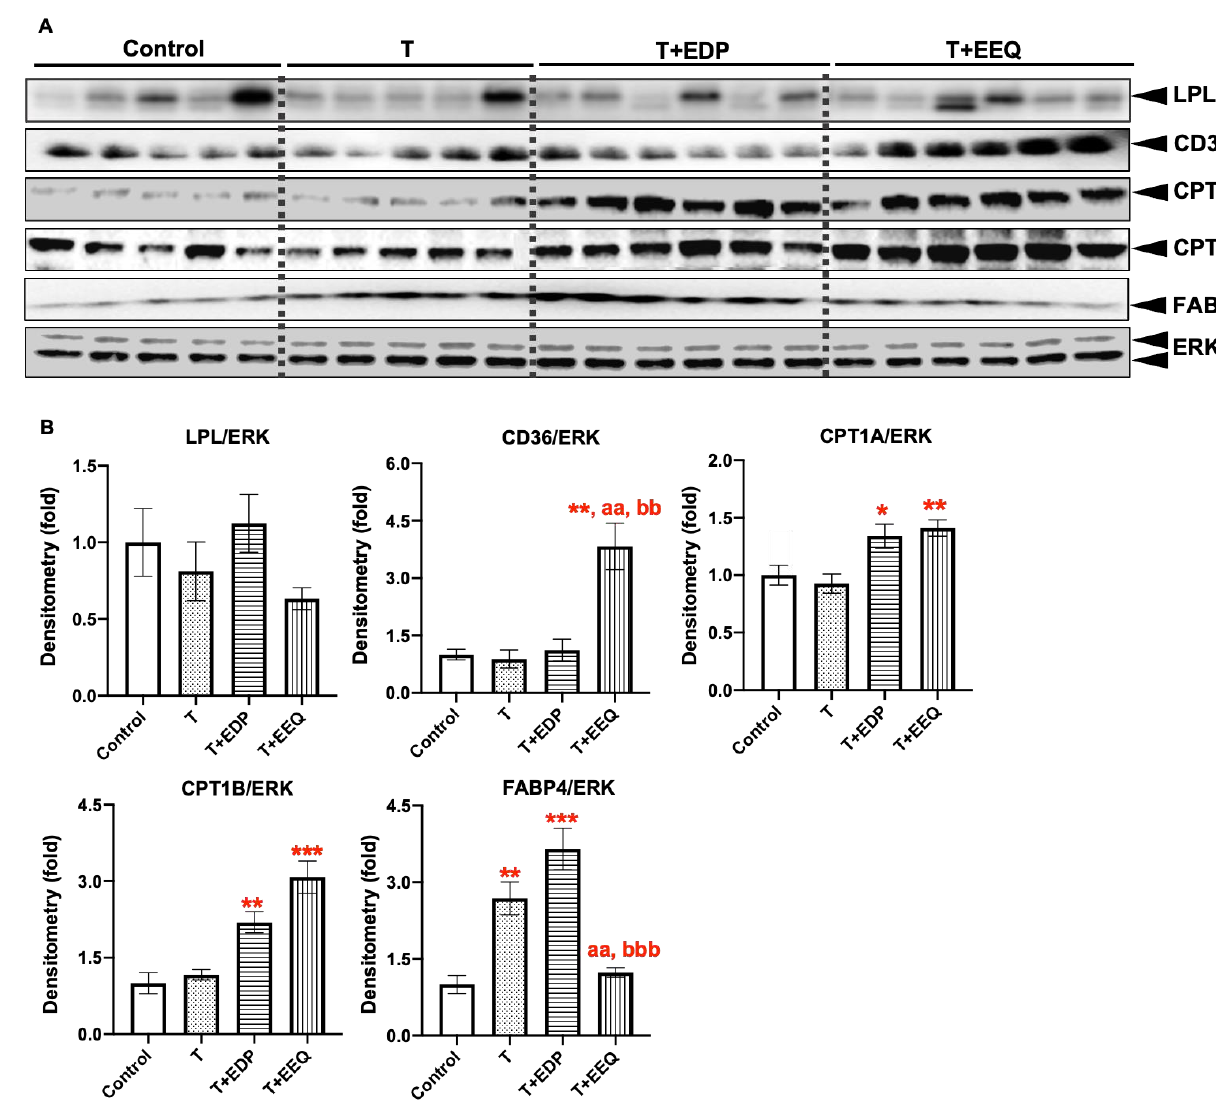
Figure 5. 17,18-EEQ or 19,20-EDP combined with t -TUCB delivered via mini osmotic pump regulated the protein expression of lipid metabolic genes in the iBAT of diet-induced obesity. Protein expression of LPL, CD36, CPT1A, CPT1B, FABP4, and the loading control ERK in the iBAT of mice in the control, T, T + EDP, and T + EEQ groups ( A ), and their densitometry ( B ) are shown. Bar graphs show the normalized densitometry for LPL/ERK1/2, CD36/ERK1/2, CPT1A/ERK1/2, CPT1B/ERK1/2, and FABP4/ERK1/2. Data = the mean ± SEM ( n = 5 – 6). *, **, and *** = p < 0.05, p < 0.01, and p < 0.001 compared to the control, respectively. aa = p < 0.01 compared to the T group. bb and bbb = p < 0.01 and p < 0.001 compared to the T + EDP group, respectively.